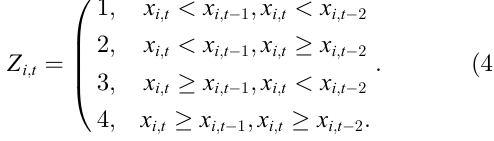
Table 4. States s 2 S and consumption behavior, coding Z i,t – see equation (4).